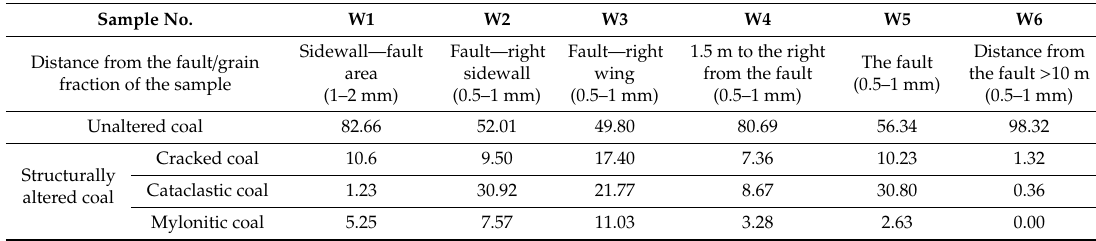
Table 1. Point analysis of coal samples (minerals not included).